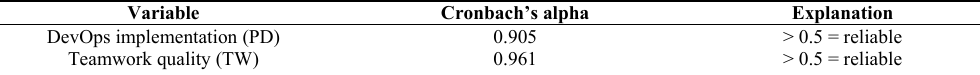
TABLE 3 T HE R ESULTS OF T HE R ELIABILITY T EST